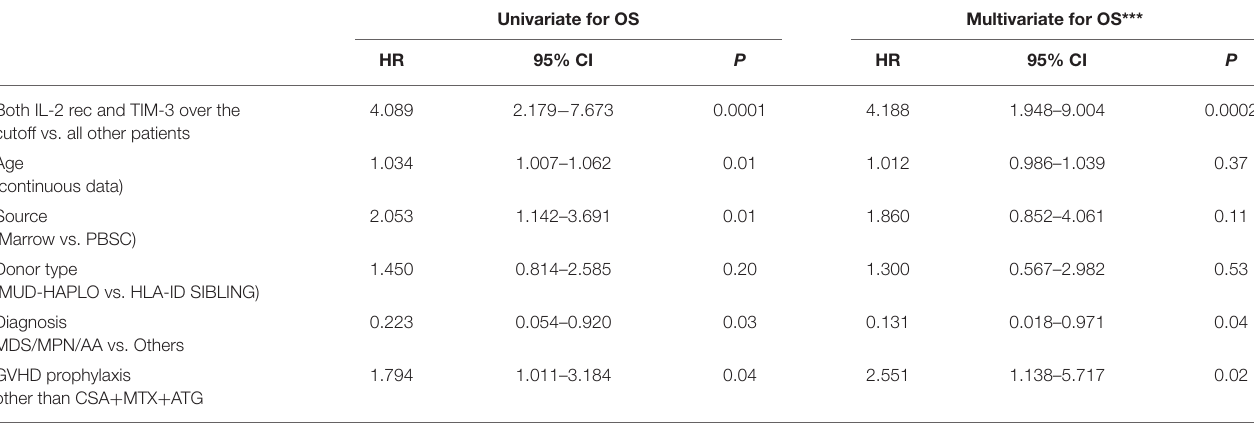
TABLE 5 | Evaluation of importance of the composite score for OS, using Cox proportional hazard multivariate analysis. Univariate for OS Multivariate for OS*** HR 95% CI P HR 95% CI P